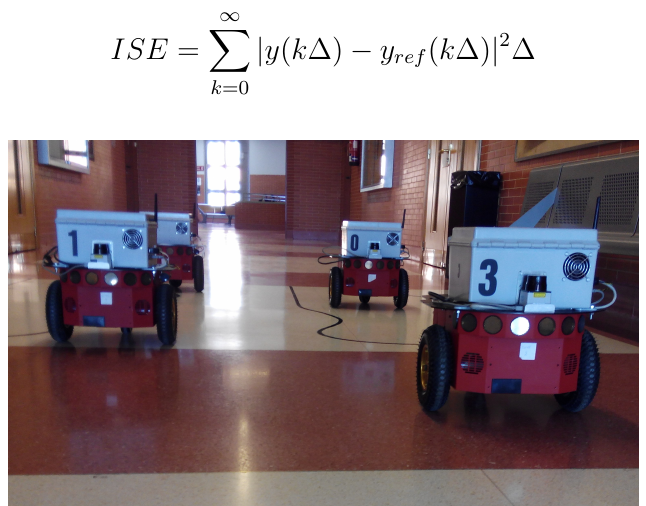
Experimental test using four P3-DX robotic units remotely controlled by a personal